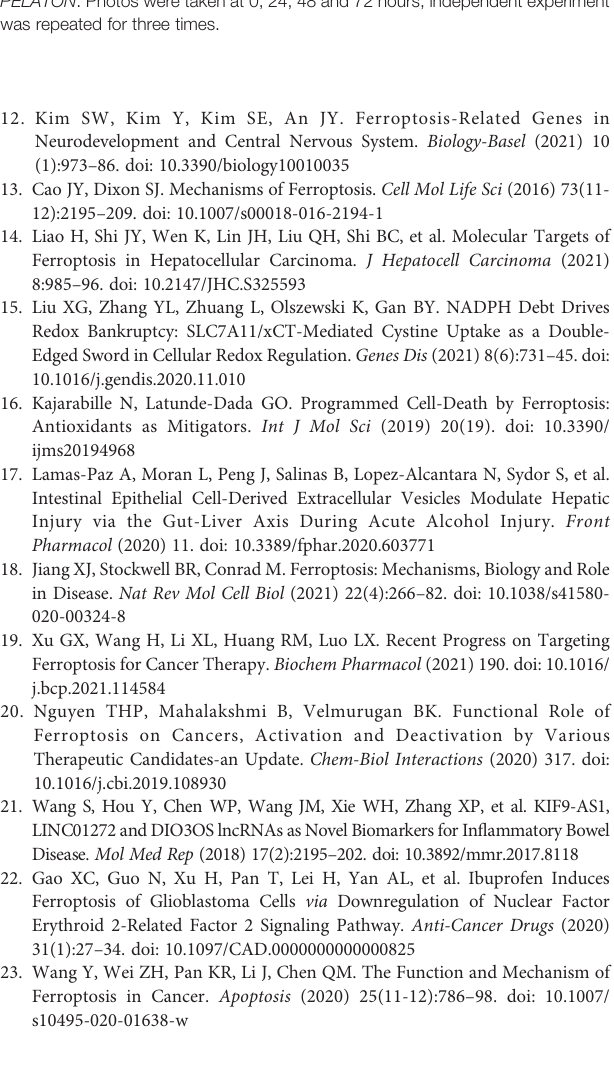
Supplementary Figure 1 | Ferroptosis-related gene clustering and identi fi cation in GBM. Sample gene clustering to detect seven outliers (A) . The FPI of gene clustering was calculated (B) . Set the soft-thresholding value to 4 (scale free R2 = 0.9, mean connectivity=115.71) (C) and cut height to 0.25 (D) . Intersection of ferroptosis driver and suppressor gene sets in FerrDb. The enrichment results of the constructing module in ferroptosis driver (E) and suppressor (F) gene sets (FDR<0.05). (F) Intersecting genes between DEGs (left, 6093) of GBM and the red module (right, 1050); 610 overlapping genes wereselected(|Log2(foldchange)| ≥ 1, andp< 0.05). Supplementary Figure 2 | Ferroptosis-related gene identi fi cation of NCOA4 and PELATON. (A) Results of the univariate Cox regression analyses of OS in the TCGA cohort. Seven genes ( PELATON, NCOA4, AL354919.2, HMOX1, AL355922.1, CD44, and ALOX5 ) were identi fi ed. (B) LASSO coef fi cient plot of 25 genes (13 mRNAs and 12 lncRNAs) correlated with ferroptosis. (C) The optimal parameter ( l ) was chosen by cross validation. The distribution of risk factors (D – E) ., Kaplan – Meier survival analysis (F) , and time-dependent ROC curves at 1, 3, and 5 years (G) between patients at high and low risk based on the NCOA4 and PELATON prognostic models in the internal set GSE43378. Supplementary Figure 3 | PELATON regulates BACH1 and CD44 in p53 - mediated ferroptosis. (A – C) KEGG analysis of the ferroptosis signalling pathway related to PELATON in GBM. (D) The expression of PELATON in U251 cells after treatmentwith3.1or3.1- PELATON (***p<0.001),Datasweremean±SEMforthree independent experiments. (E) The expression of PELATON in PG-3 glioma primary cells after treatment with siRNAs (si226, si342, and si478), Datas were mean ± SEM for three independent experiments. (**p < 0.01). (F – G) RNA level changes of BACH1